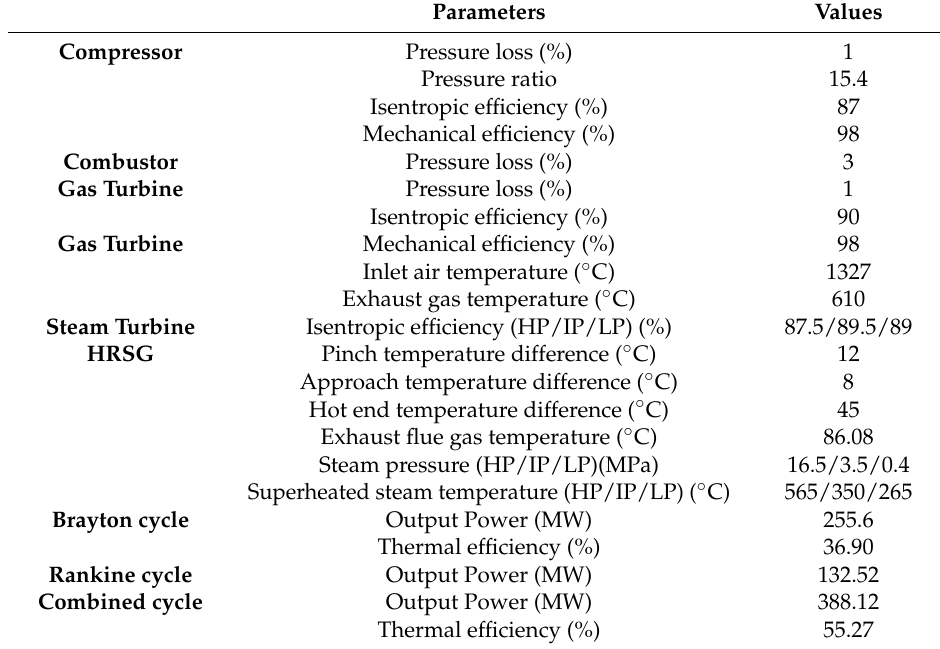
Table 3. Design and simulation data of gas turbine combined cycle (GTCC) system.